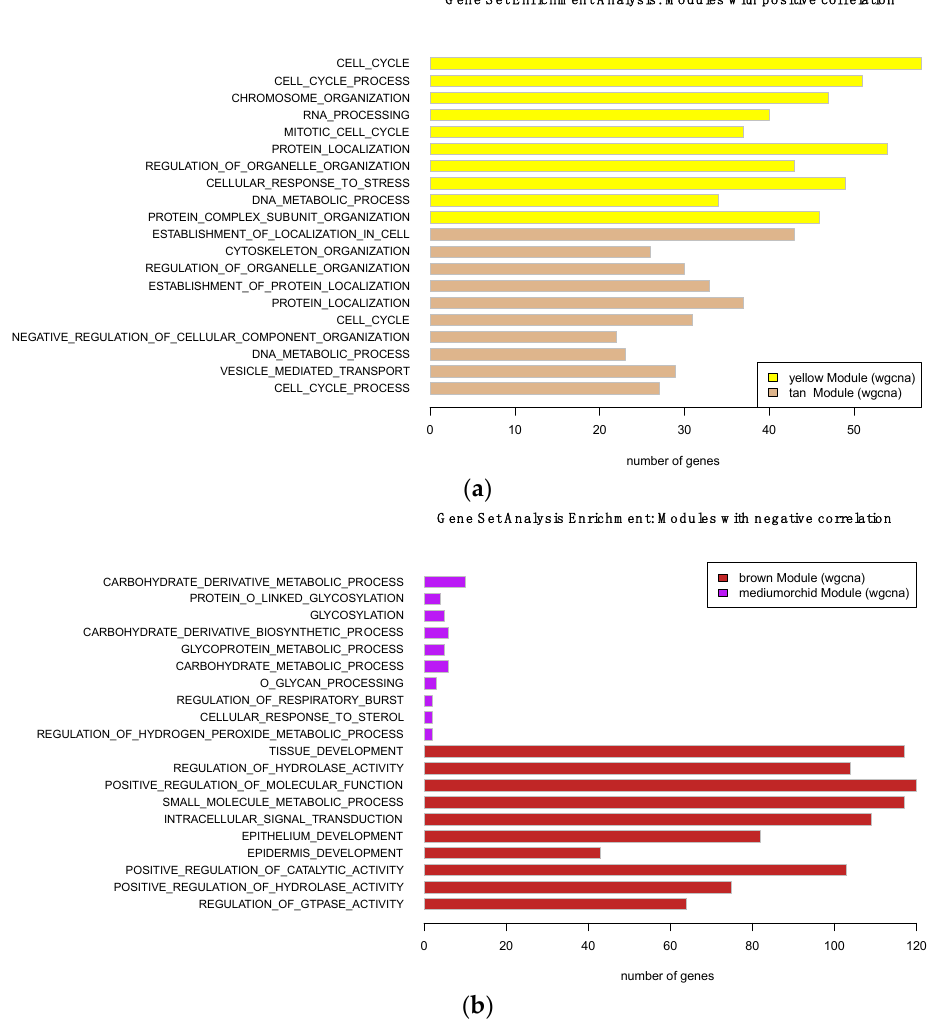
Figure 5. GO terms (Biological Process) enriched for ( a ) positively correlated and ( b ) negatively correlated modules with oral melanoma: the top ten enriched GO items are represented.